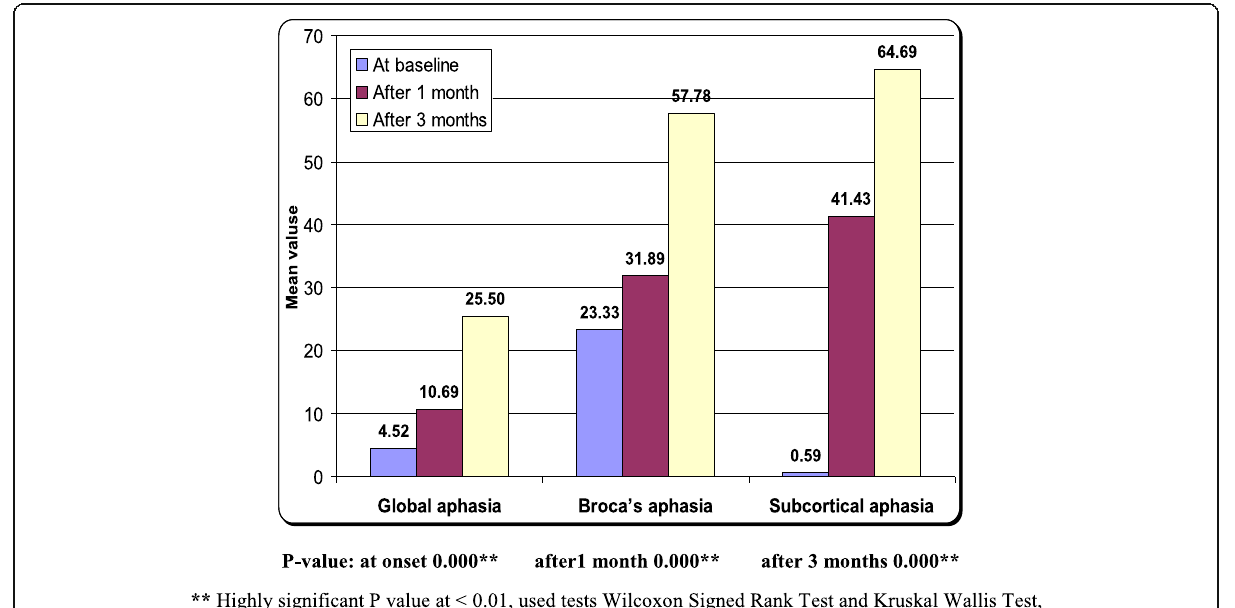
Fig. 2 Comparing KAAT score at follow-up for the most frequent aphasia subtypes (global, Broca ’ s, and